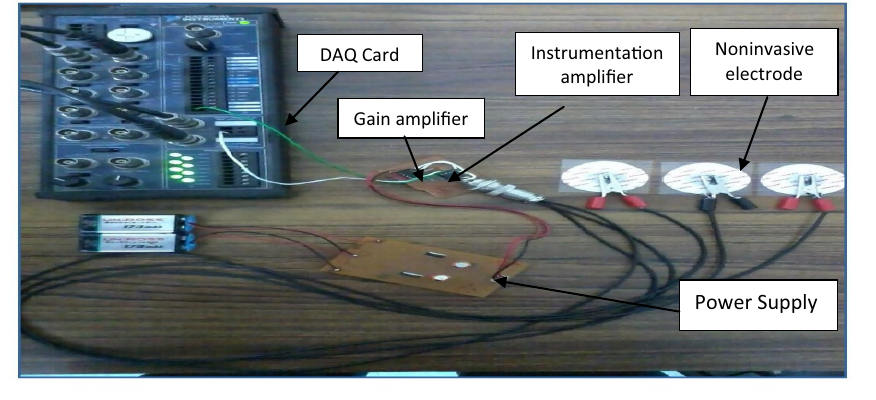
Fig. 4. Figure of the entire testing system. Table 2. Feature extracted values for biceps